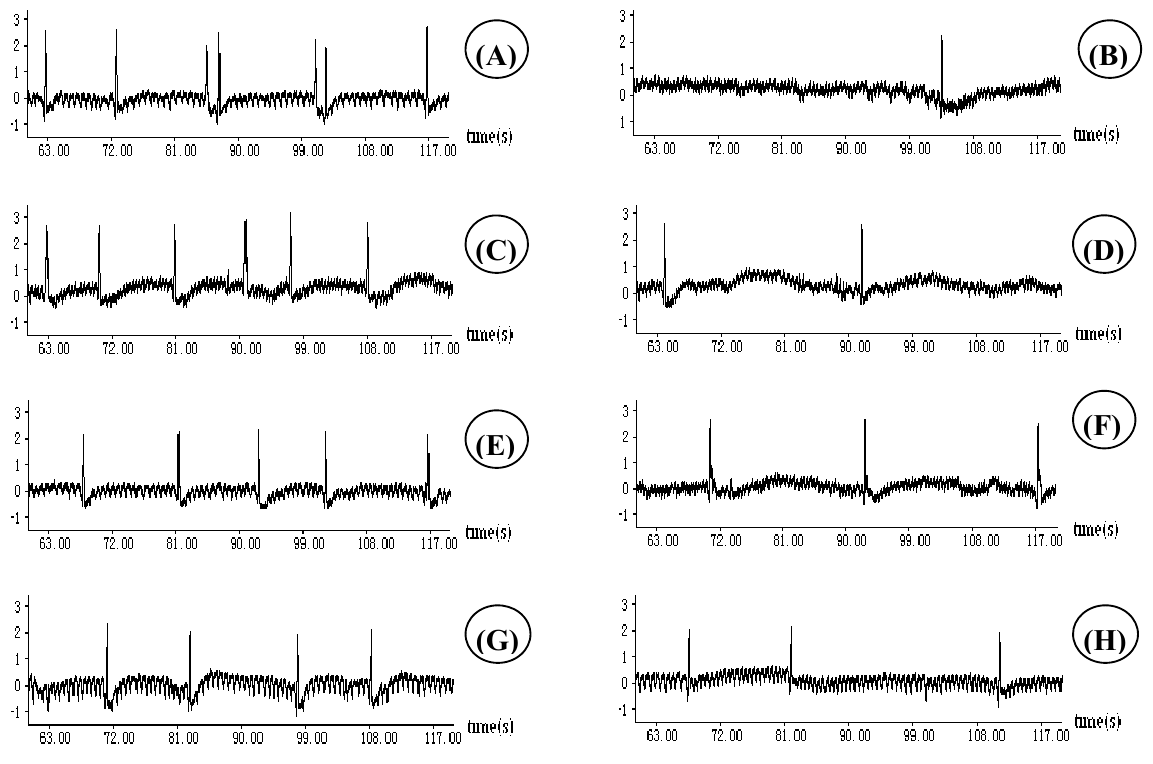
Figure 1. Effect of extracts of Pseudostellaria heterophylla at the dose 400 mg/kg on respiratory waves of guinea pigs recorded by a pressure transducer connected to a biology signal collection processing system: (A) citric acid induced. (B) codeine phosphate + citric acid. (C) PEF + citric acid. (D) EtOAcF + citric acid. (E) n- BOHF + citric acid. (F) EtOHE + citric acid. (G) WE + citric acid; (H) Guilong Kechuanning + citric acid.